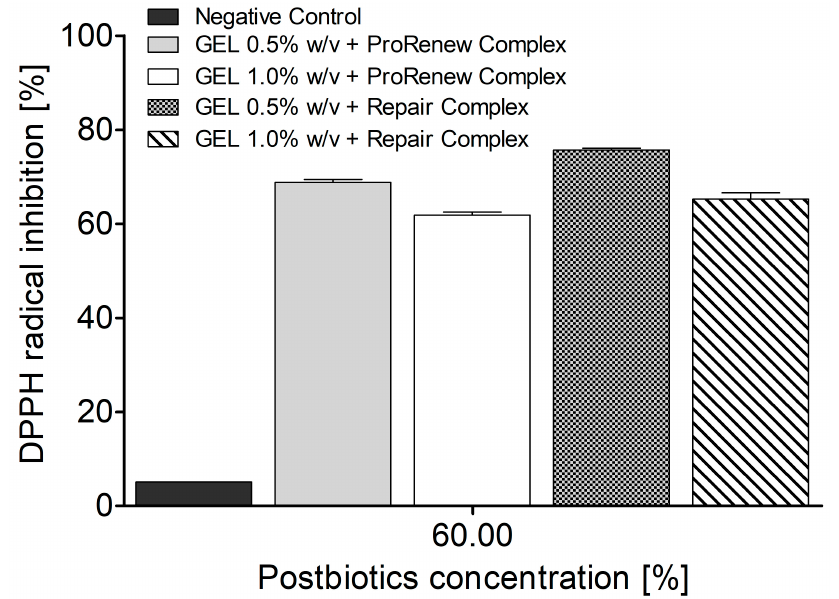
Figure 6. DPPH radical inhibition (%) by POSTBIOTICS in gels with different amounts of Boc-L- DOPA(Bn) 2 -OH (0.5% and 1.0% w / v ) (mean value ± SD, n = 3). Negative control presents solution of L-DOPA in DMSO.